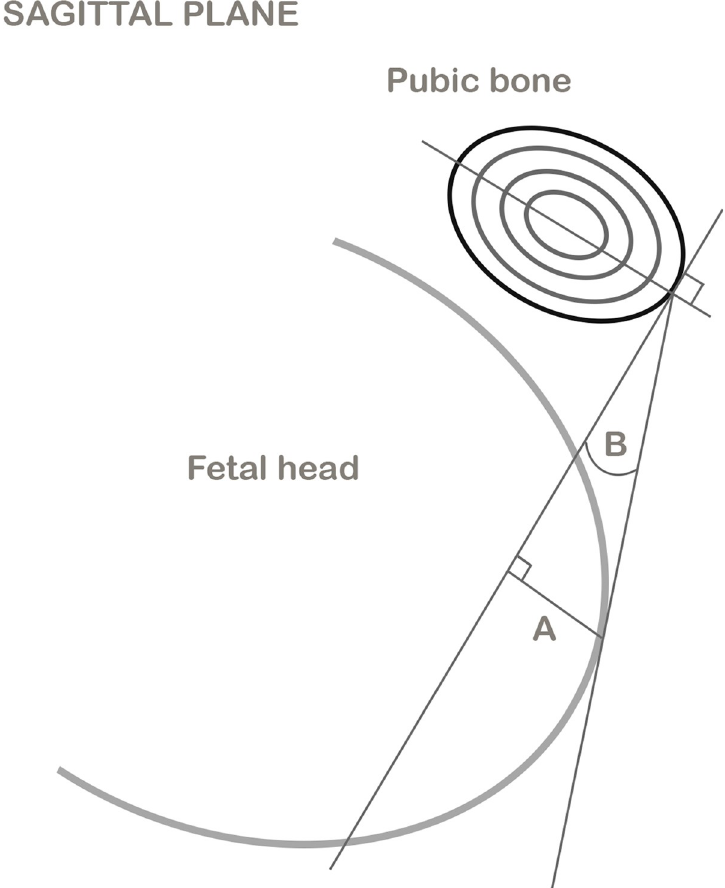
Fig 1. Measure of the height reached by the fetal presentation during labor. The height reached by the fetal presentation during labor was evaluated according to imaging criteria proposed by Dietz et al. The measurement method consisted of the definition of a perpendicular reference to the major axis of the symphysis pubis in the sagittal plane through the lower edge of the pubis, and the measurement of the height of the descent of the lowest point of the fetal head compared to this reference line (A), as well as measuring the difference in height between prelabor and the second stage of labor. The angle of progression was also measured (B). This angle was described by Barbera et al. [9], and represents the angle between a line placed through the midline of the pubic symphysis and a line running from the inferior apex of the symphysis perpendicular to the pubic midline, and to the most anterior part of the fetal skull.